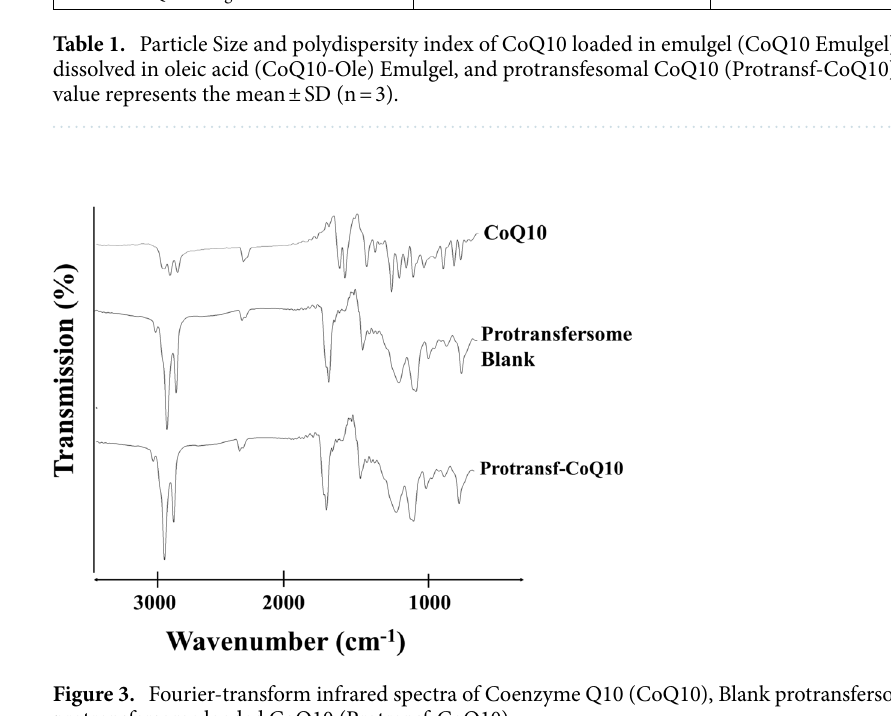
Figure 3. Fourier-transform infrared spectra of Coenzyme Q10 (CoQ10), Blank protransfersome, and protransfersome loaded CoQ10